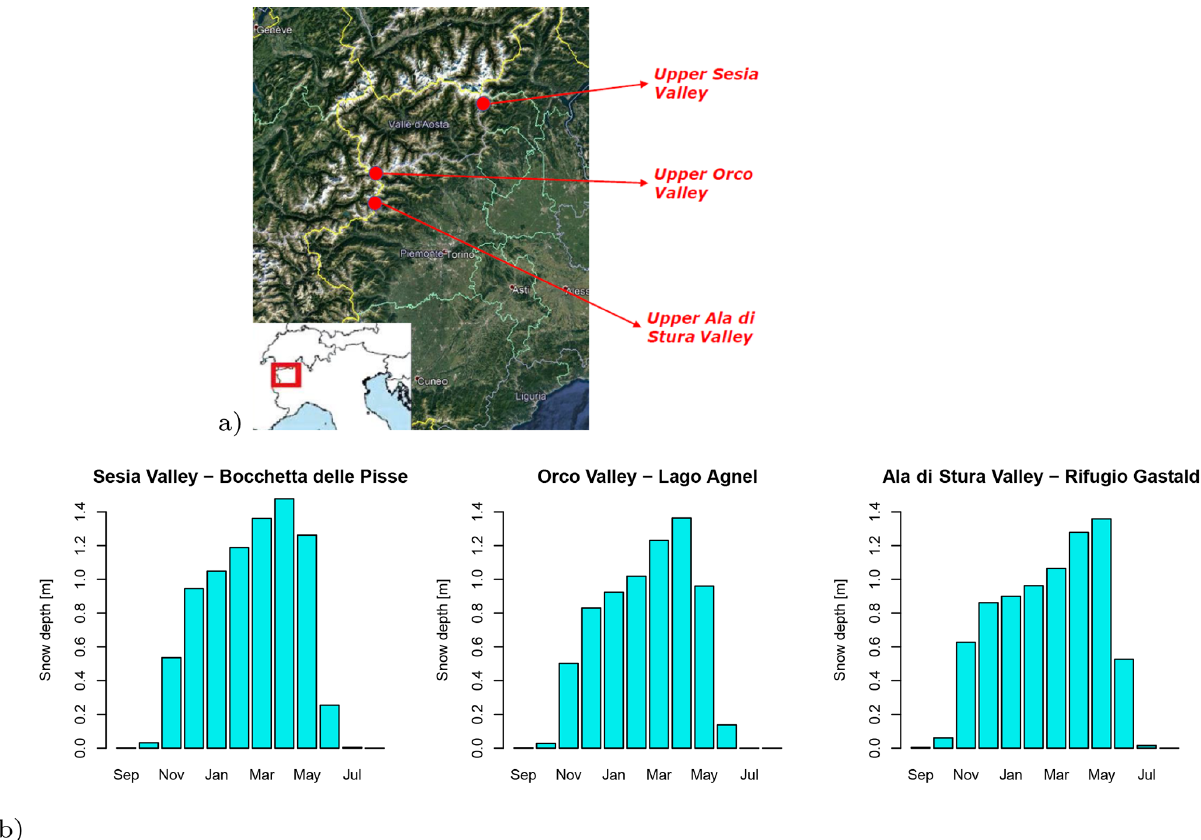
Figure 1. (a) Map of the study sites indicating the three nivo-meteorological stations in the NW Italian Alps (© Google Maps 2021). (b) Snow depth climatology at the three stations considered in this study and described in Table 1. Averages are calculated over the period 1998–2015. Table 1. Stations considered in this study, elevation, position and date of start of automatic meteorological station